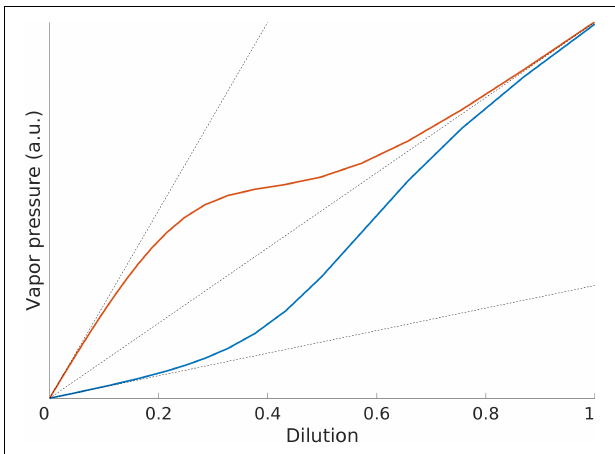
FIGURE 1 | Illustration of Henry’s and Raoult’s laws. Both k H > p ∗ (red line) and k H < p ∗ (blue line) can be observed for different